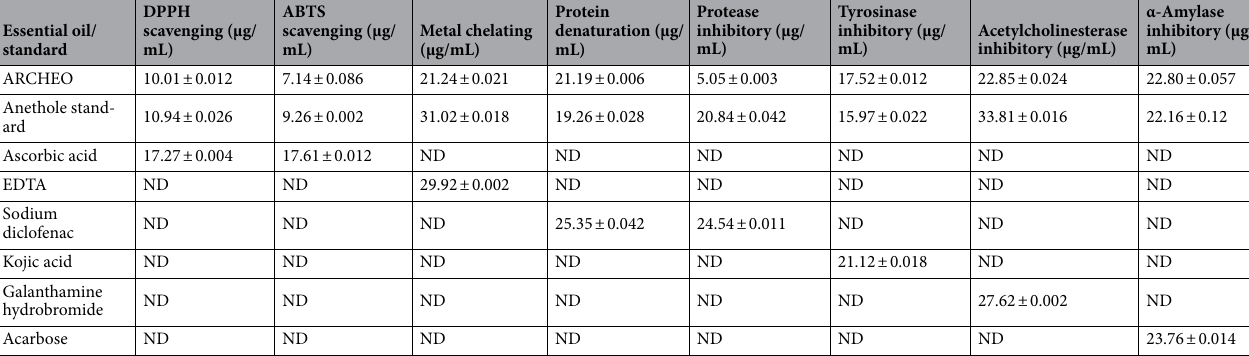
Table 2. 50% Inhibition concentrations (IC 50 ) determination values for pharmacological activities of ARCHEO and standards using MS-EXCEL software. ARCHEO anethole rich C. heptaphylla essential oil, ND not determined.